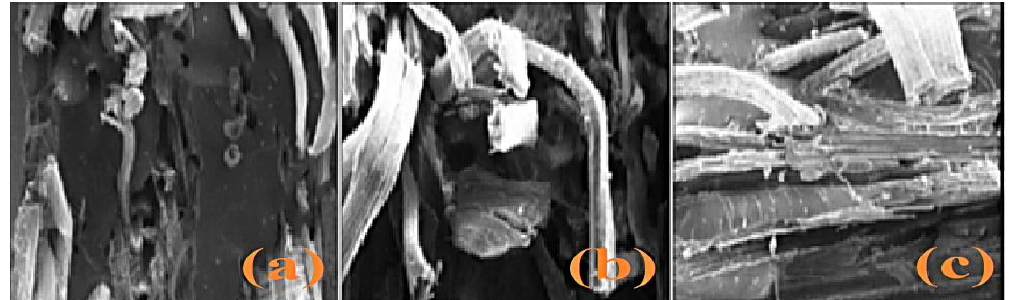
Figure 17. ( a – c ) SEM images of the flexural fractured specimen at different fiber loading, ( a ) 25 wt. %, ( b ) 35 wt. %, and ( c ) 45 wt. % of pineapple-reinforced polyester composites. Reprinted with permission from Reference [95]. Copyright 2019, with permission from Elsevier.